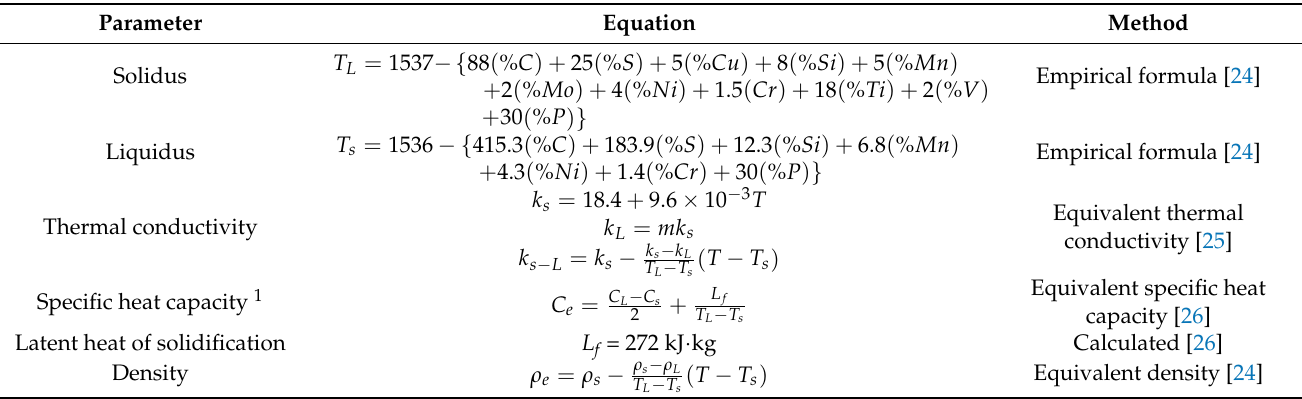
Table 3. Main thermophysical